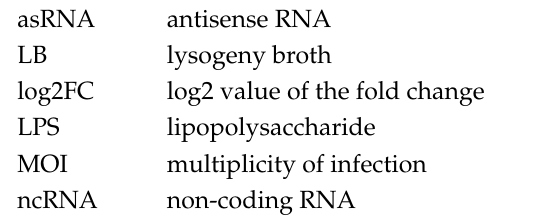
Figure S1 : The Bioanalyzer electropherograms of total RNA isolated from the bacteria at different time points post-infection, Figure S2 : The time-wise degradation of the host RNA during phage ϕ R1-37 infection, Table S1 : The number of reads that mapped to YeO3-R1 and phiR1-37 genomes, Figure S3 : Principal component analysis (PCA) graph presenting the correlation between all the samples used in this study, Table S2 : Expression pattern of phiR1-37 genes and their promoters, Figure S4 . High resolution image of Figure 3A. Figure S5 : The conservation of phage phiR1-37 promoters generated using the Meme-Suite, Table S3 : Bacterial genes differentially expressed between the early time points of phiR1-37 infection (2–5 min) and the negative control, Table S4 : Bacterial genes differentially expressed between the late time points of phiR1-37 infection (28–49 min) and the negative control, Table S5 : Bacterial genes differentially expressed between the late and the early time points of phiR1-37 infection, Figure S6 : The nucleotide